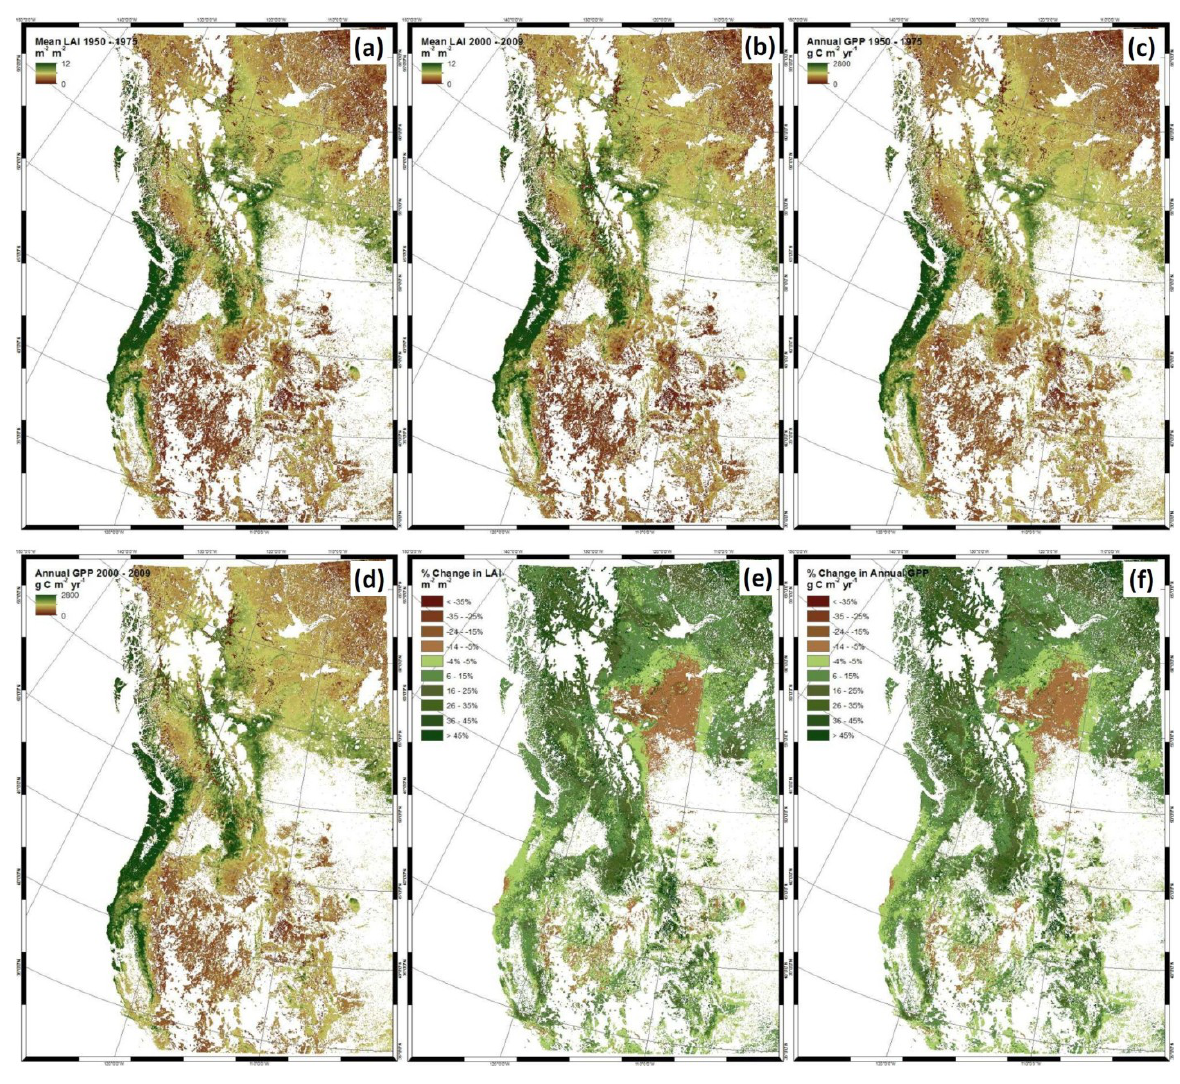
for Douglas-fir (maximum 12.0 m 2 m −2 ) max